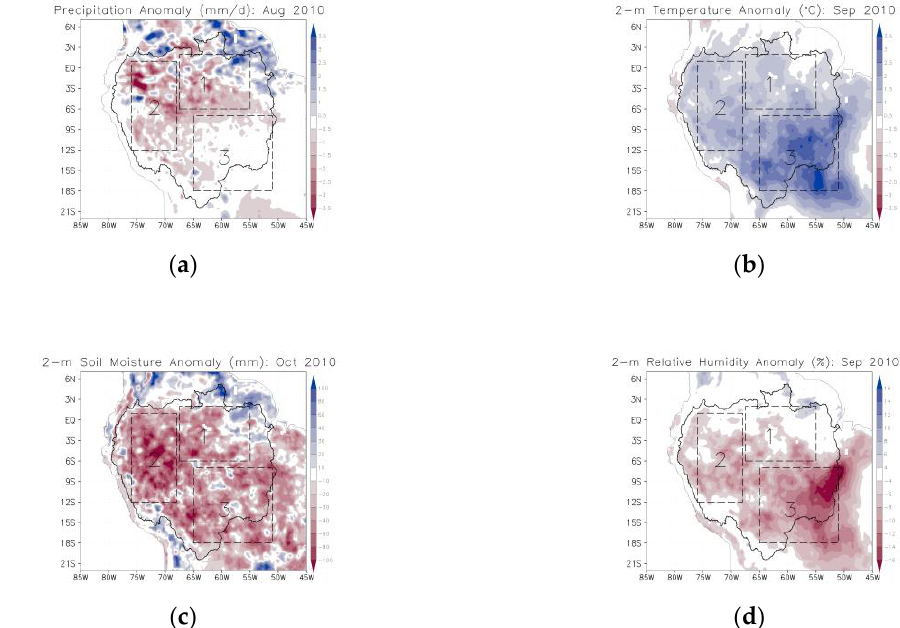
Figure 11. The 2010 drought anomaly fields of: ( a ) precipitation in August (mm/d); ( b ) temperature at 2-m above ground in September ( ◦ C); ( c ) 2-m integrated soil moisture in October (mm); ( d ) relative humidity at 2-m above ground in September (%). Boxes (dashed lines) delimit areas north (1), west (2), and southeast (3). Solid black contour encompasses the Amazon basin.